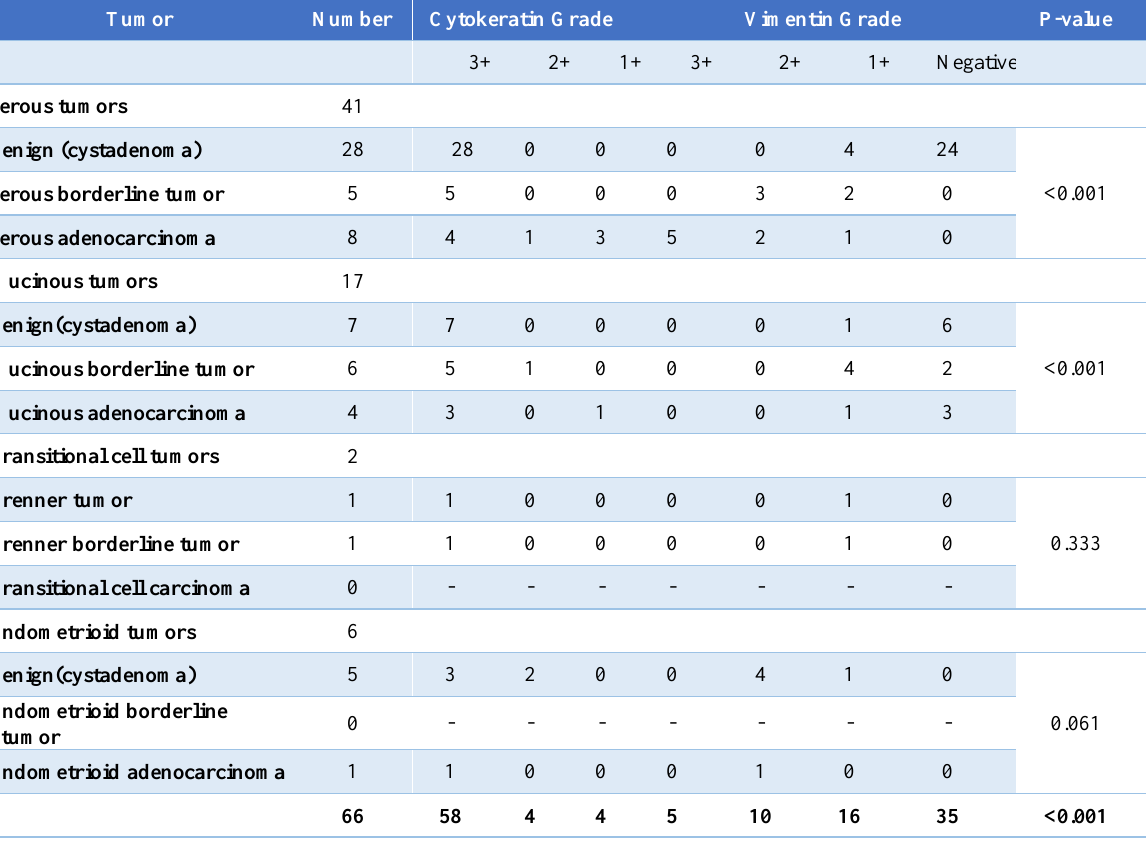
Table 1. Detection of Cytokeratin and Vimentin in Common Epithelial Ovarian Neoplasms